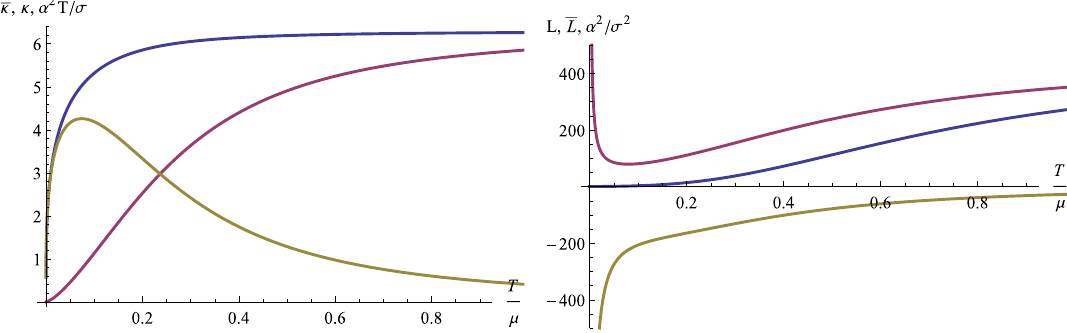
Figure 9 . Left: thermal conductivities (cid:22) (cid:20) (Blue) and (cid:20) (Purple) and the di(cid:11)erence between the two of them (cid:11) 2 T=(cid:27) (Yellow) as a function of the reduced temperature. Right: Wiedemann-Franz ratios L (Blue) and (cid:22) L (Purple) and the di(cid:11)erence between these two (cid:11) 2 =(cid:27) 2 (Yellow) as a function of the